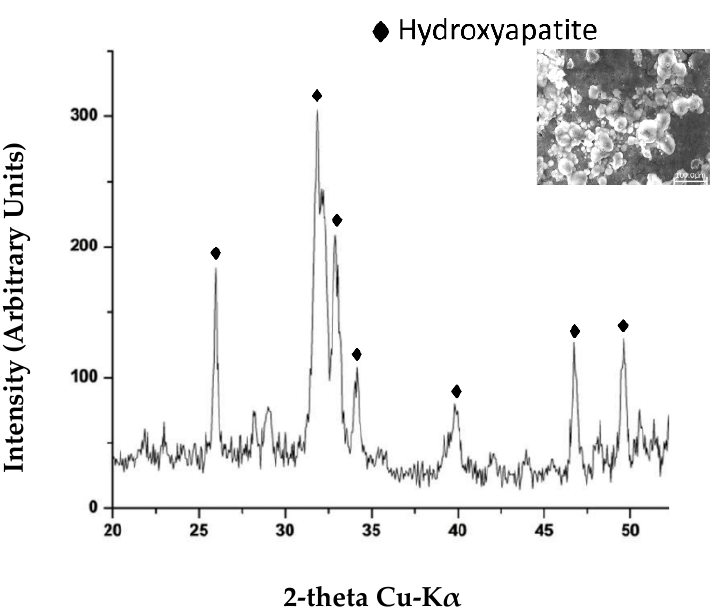
Figure 7. A representative XRD of SiO 2 /PEG 50 wt % /CGA 20 wt % soaked in SBF solution for 21 days.